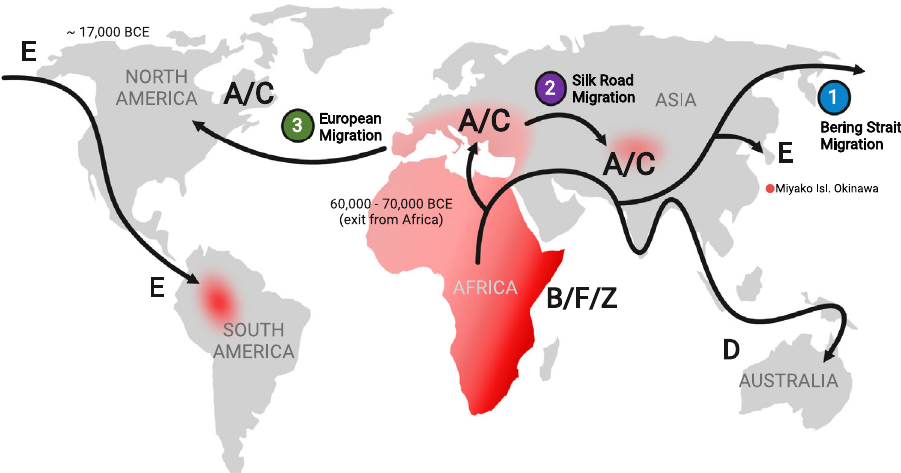
Fig. 2 Global patterns of KSHV spread with KSHV endemic and hyperendemic areas (red). Molecular epidemiology studies indicate that KSHV evolved with humans and spread primarily through human migrations. KSHV D and E strains may represent modern remnants of an ancestral KSHV strain migrating with early humans that was subsequently lost from most Asian and European populations after settlement, leaving endemic and hyperendemic geographic pockets in Okinawan islands and in South America. Additional viral strains (e.g., A, B, C, and Z) appear to have re-emerged in Africa and the spread of some strains may represent secondary out-migrations to Mediterranean, Western Chinese, and North American populations within historical periods. Unlike other human herpesviruses, KSHV is not ubiquitous and current global patterns are consistent with the potential for human immune clearance of this